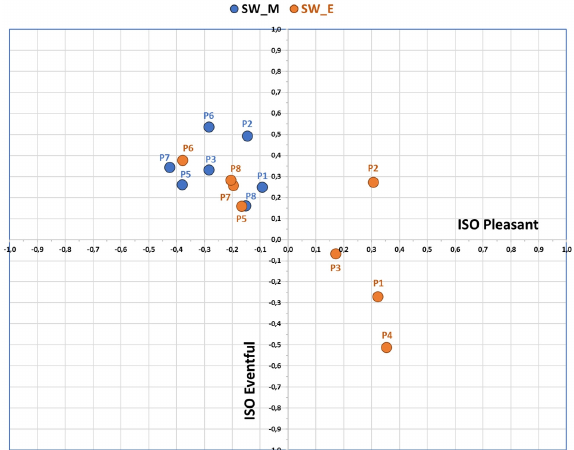
Figure 16: Pleasantness (P) and Eventfulness (E) as derived from ISO 12913-3 formulae and Q5 data at every stop in the path during SW_M and